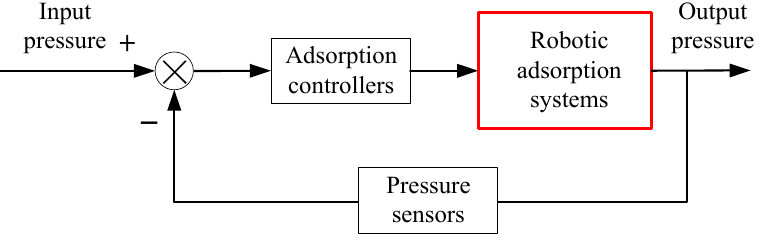
Figure 15. Closed-loop control system for adsorption.